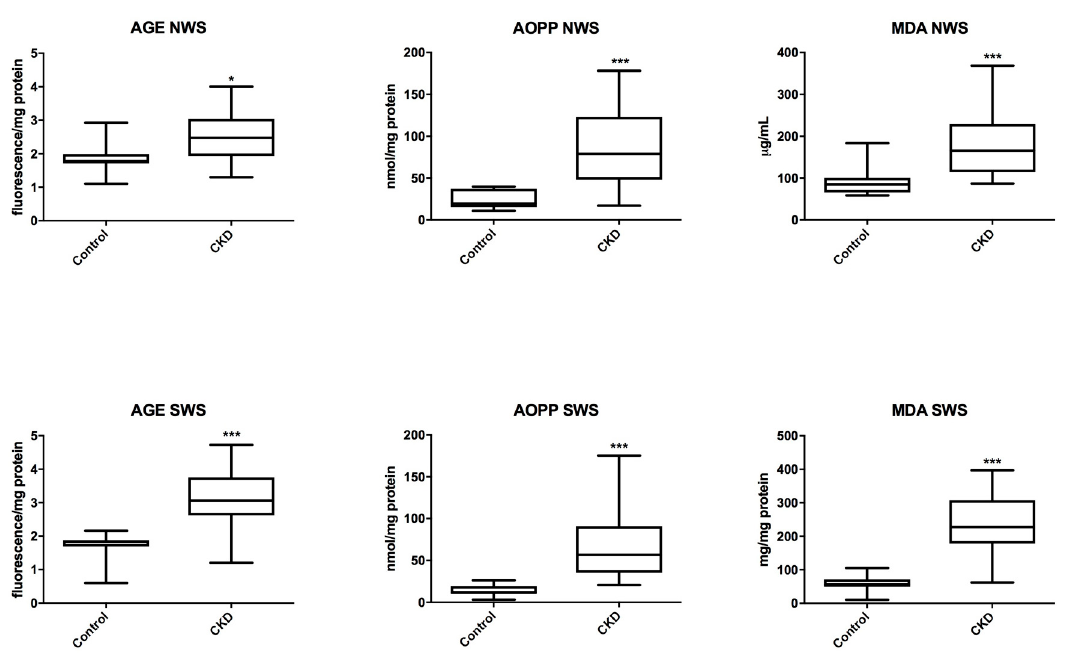
Figure 4. Salivary markers of oxidative damage in children with chronic kidney disease (CKD) and the controls. AGE, advanced glycation end products; AOPP, advanced oxidation protein products; MDA, malondialdehyde; NWS, non-stimulated whole saliva; SWS, stimulated whole saliva. Differences statistically important at: * P < 0.05, *** P < 0.0005.